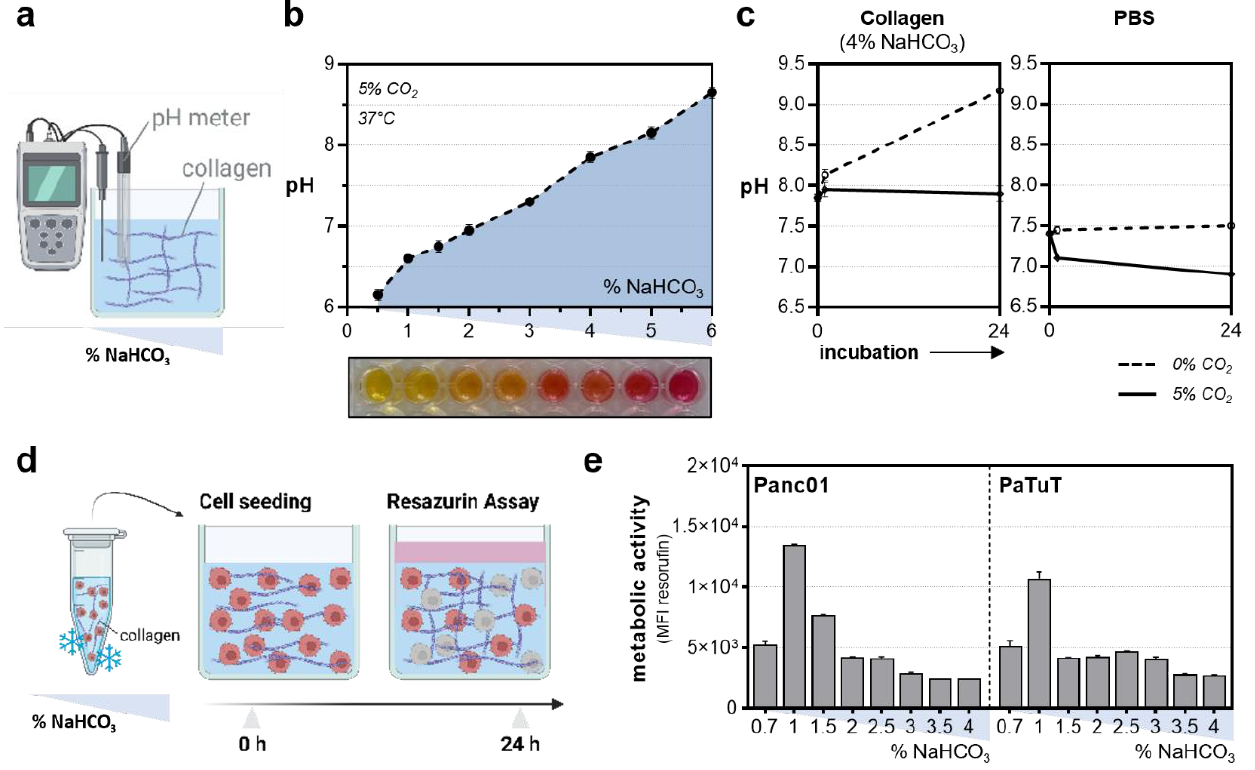
Figure 2. Establishment of collagen hydrogel cultures. ( a ) Schematic overview of the pH measurement using a pH meter; ( b ) pH levels in the different collagen formulations; ( c ) influence of the CO 2 supply under standard incubation conditions on pH levels in a collagen-based hydrogel and PBS; ( d ) experimental procedure to optimize collagen culture conditions for cell culture purposes; ( e ) metabolic activity of Panc01 and PaTuT cells 24 h after incubation with collagen at different concentrations of sodium bicarbonate (NaHCO 3 ). The graphs show the mean ± standard error of the mean (SEM). MFI = mean fluorescence intensity.